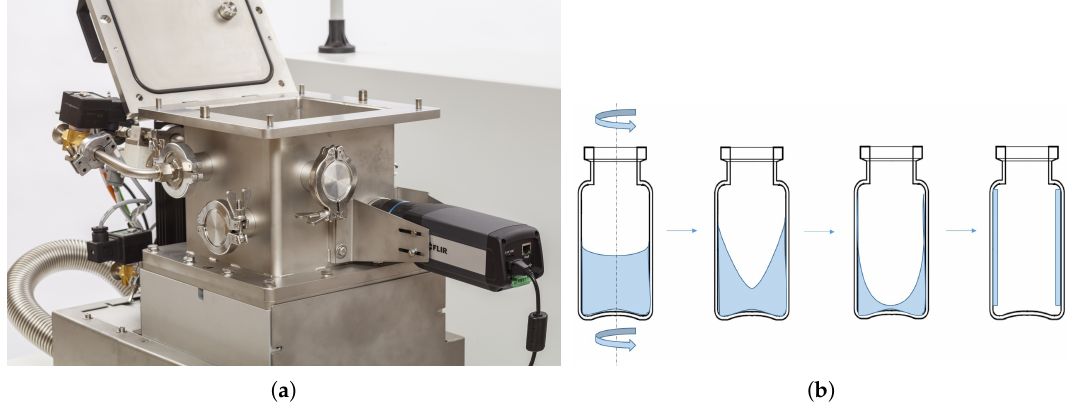
Figure 1. ( a ) Picture of a Rheavita spin-freezer with the thermal camera in front of a germanium window and ( b ) the graphical representation of the spin-freezing concept. Adapted with permission from Corver J., Eur. Pharm. Rev.; published by Russell Publishing Ltd.,